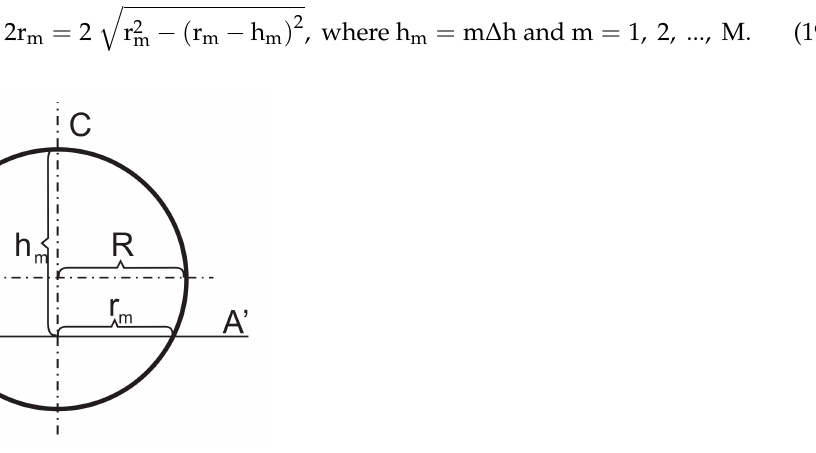
Figure 9. A bubble, with radius R, cut with a plane AA’, where r m is the radius of the m-th